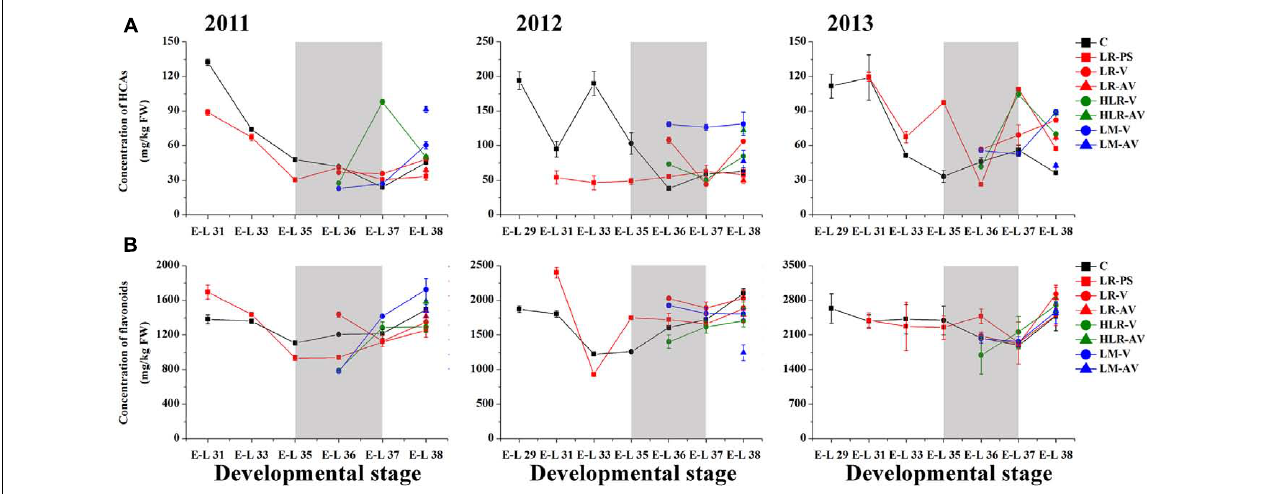
FIGURE 2 | Changes of the accumulation of (A) hydroxycinnamic acids (HCA) and (B) total flavonoids in different cluster sunlight exposed grape berries during development over three seasons. C, control group; LR-PS, leaf removal at berry pea-size; LR-V, leaf removal at véraison; LR-AV, leaf removal after véraison; HLR-V, half leaf removal at véraison; HLR-AV, half leaf removal after véraison; LM-V, leaf moving at véraison; LM-AV, leaf moving after véraison. Data are mean ± SD of three biological replicates. Light gray background represents the phenological phase of véraison from 5 to 100% of colored